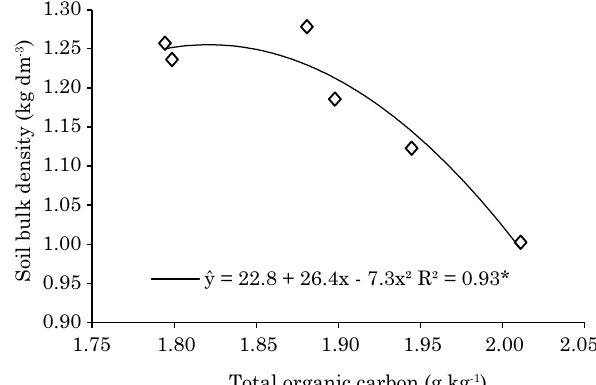
figure 1. relationship between soil bulk density and concentration of total organic carbon throughout the soil at the depth of 0.00-0.10 m. the diamond symbol means the average of soil bulk density for the respective total organic carbon in each cover crop